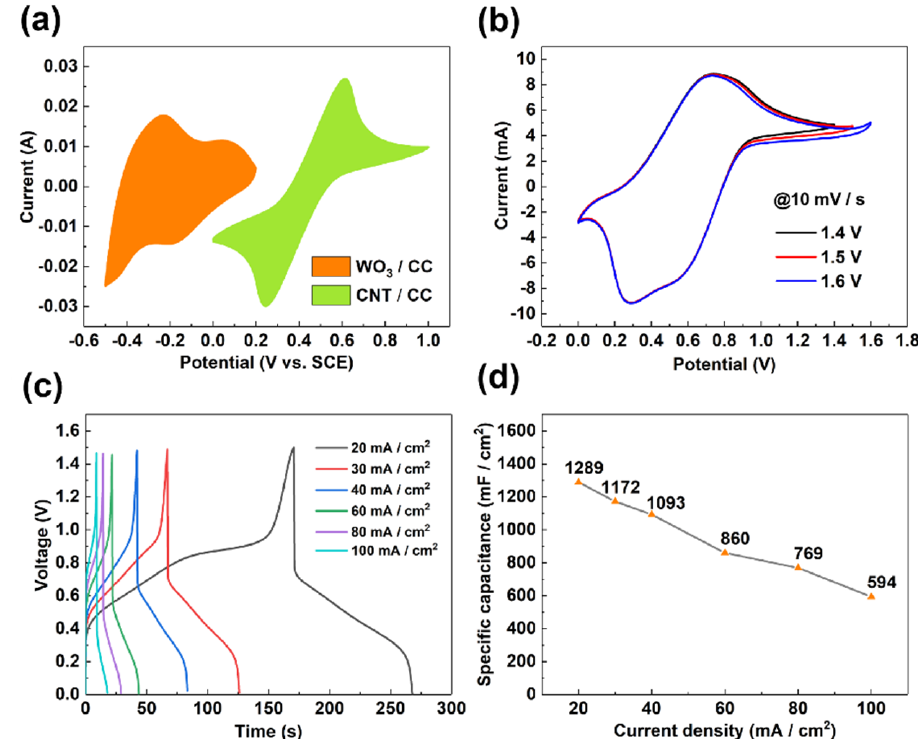
Figure 7. Electrochemical behavior of the ASC device with the configuration of CNT/CC/0.2 M Fe 2+/3+ + 1 M H 2 SO 4 //1 M H 2 SO 4/ WO 3 /CC. ( a ) CV curves of CNT/CC electrode in 0.2 M Fe 2+/3+ + 1 M H 2 SO 4 electrolyte and WO 3 /CC electrode in 1 M H 2 SO 4 electrolyte at 10 mV/s; ( b ) CV curves of the ASC operated in different voltage windows; ( c ) GCD curves of the ASC at different current densities; and ( d ) the specific capacitance of the ASC under different current densities.